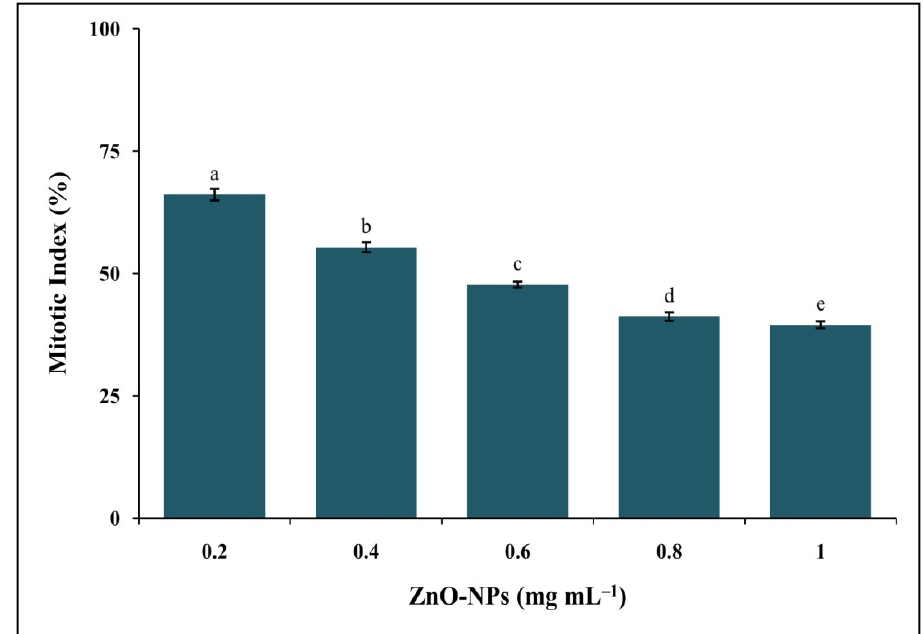
Figure 7. Genotoxic potential of phyto-fabricated ZnO-NPs from I. obscura aqueous leaf extract. Each value is the mean for three replicates (n = 3) and bars sharing the same letters are not significantly different ( p ≤ 0.05) according to Tukey’s HSD. The vertical bar indicates the standard error.